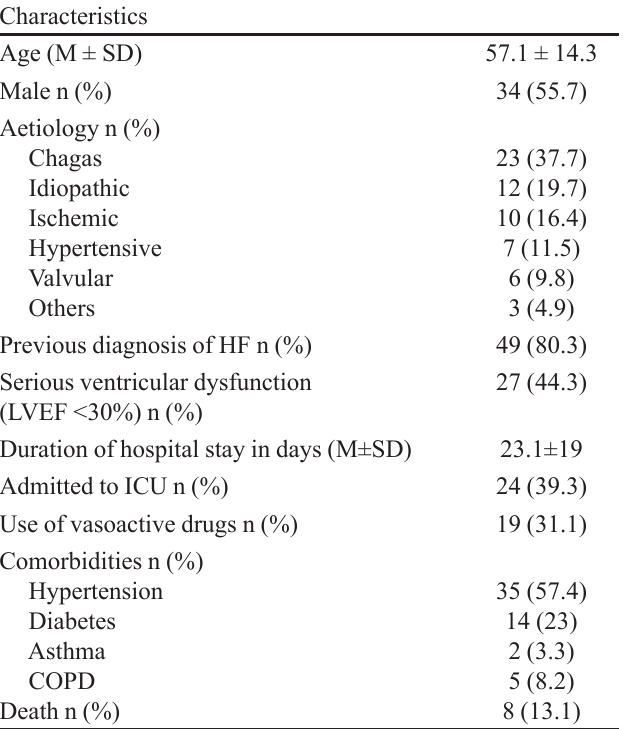
TABLE II - Patient characteristics (N = 61) Characteristics